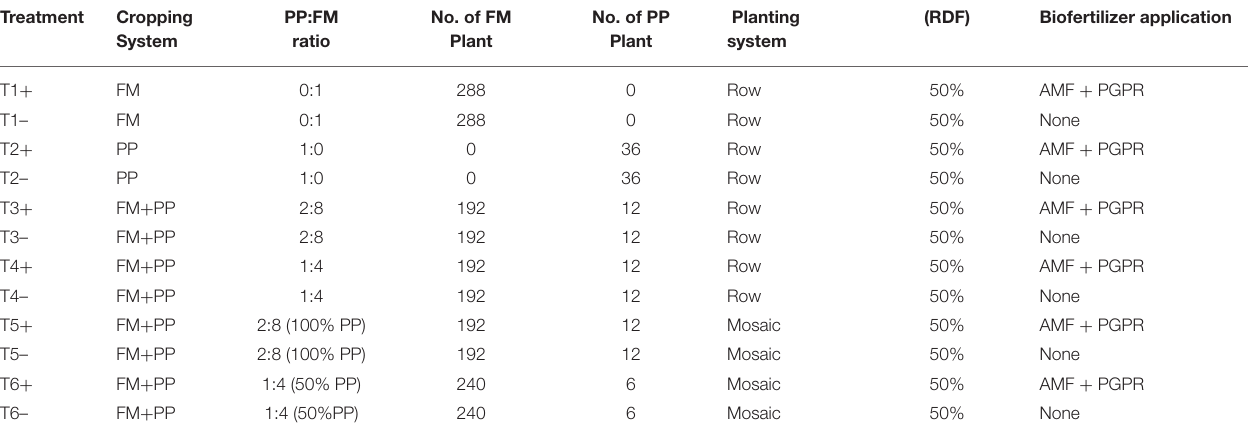
TABLE 1 | Intercropping treatments with (AMF + PGPR) and without (none) biofertilizer application were designed and tested at two experimental sites, Bengaluru and Kolli Hills in India.